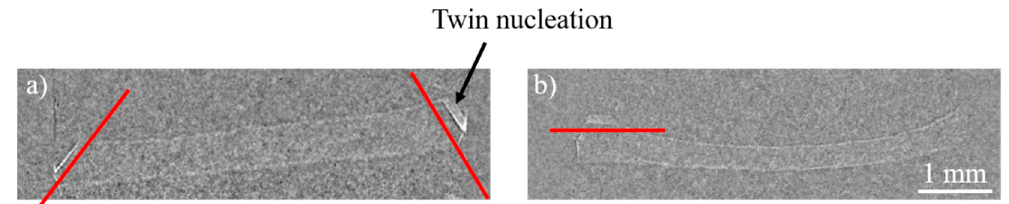
Figure 5. X-ray radiography images of the solid–liquid interface during growth with {111} facets at both edges of the sample for the experiments: ( a ) same experiment as in Figures 2 and 6a, ( b ) same experiment as in Figure 6c. Red lines indicate the traces of {111} planes.